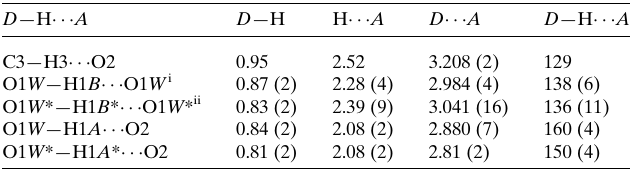
Table 1 Hydrogen-bond geometry (A˚ , (cid:5)